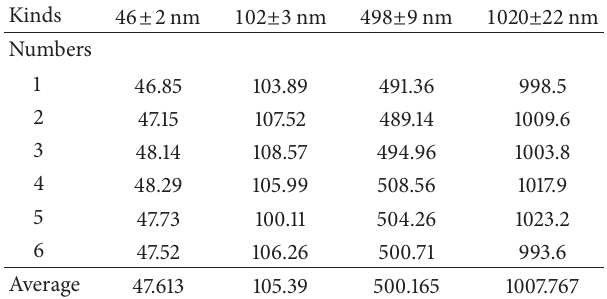
Table 1: Measured sizes of 4 kinds of polystyrene particles.